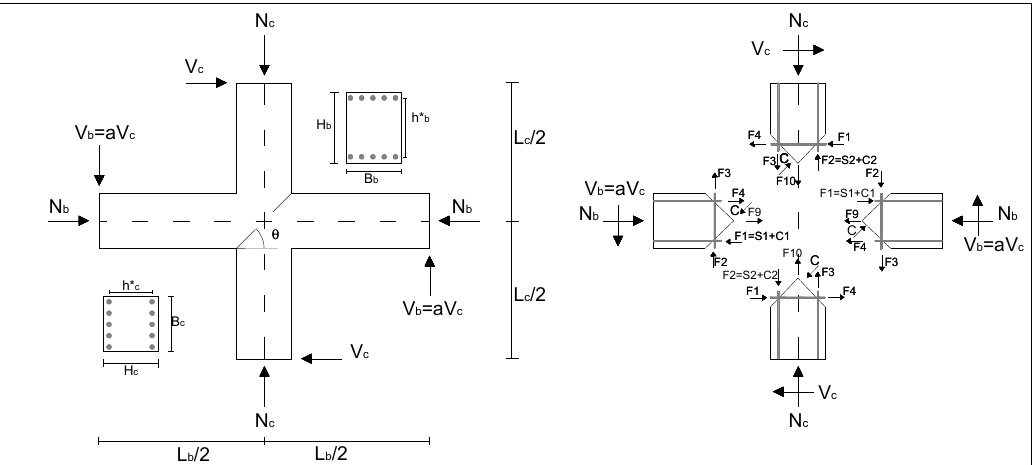
Figure 2. Internal perimetric joint: geometry, internal distribution of forces.